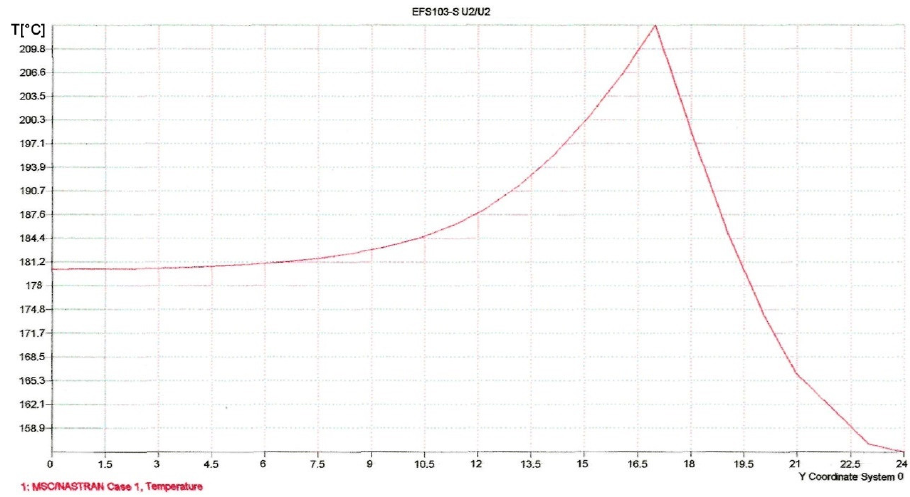
Figure 13. Thermal loading of the rings for EFS 103 − S, U2/U2, along the interface.